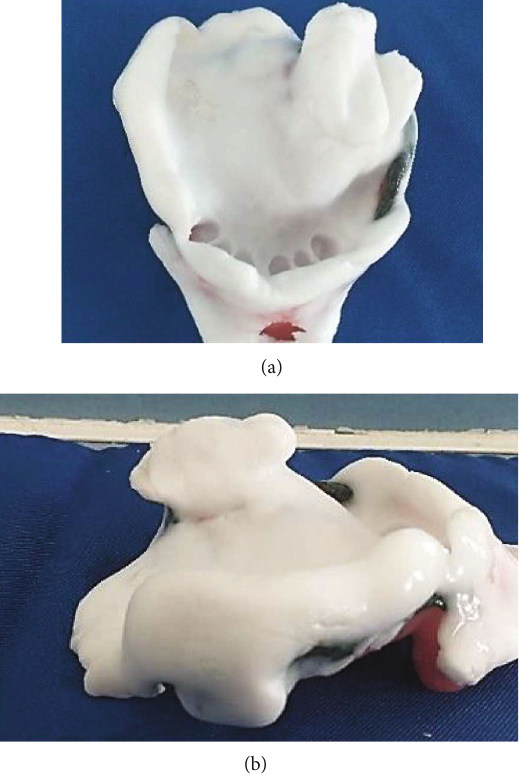
Figure 5: Primary impressions. Figure 6: Anatomofunctional impression with FITT material: (a) upper view; (b) lateral view.